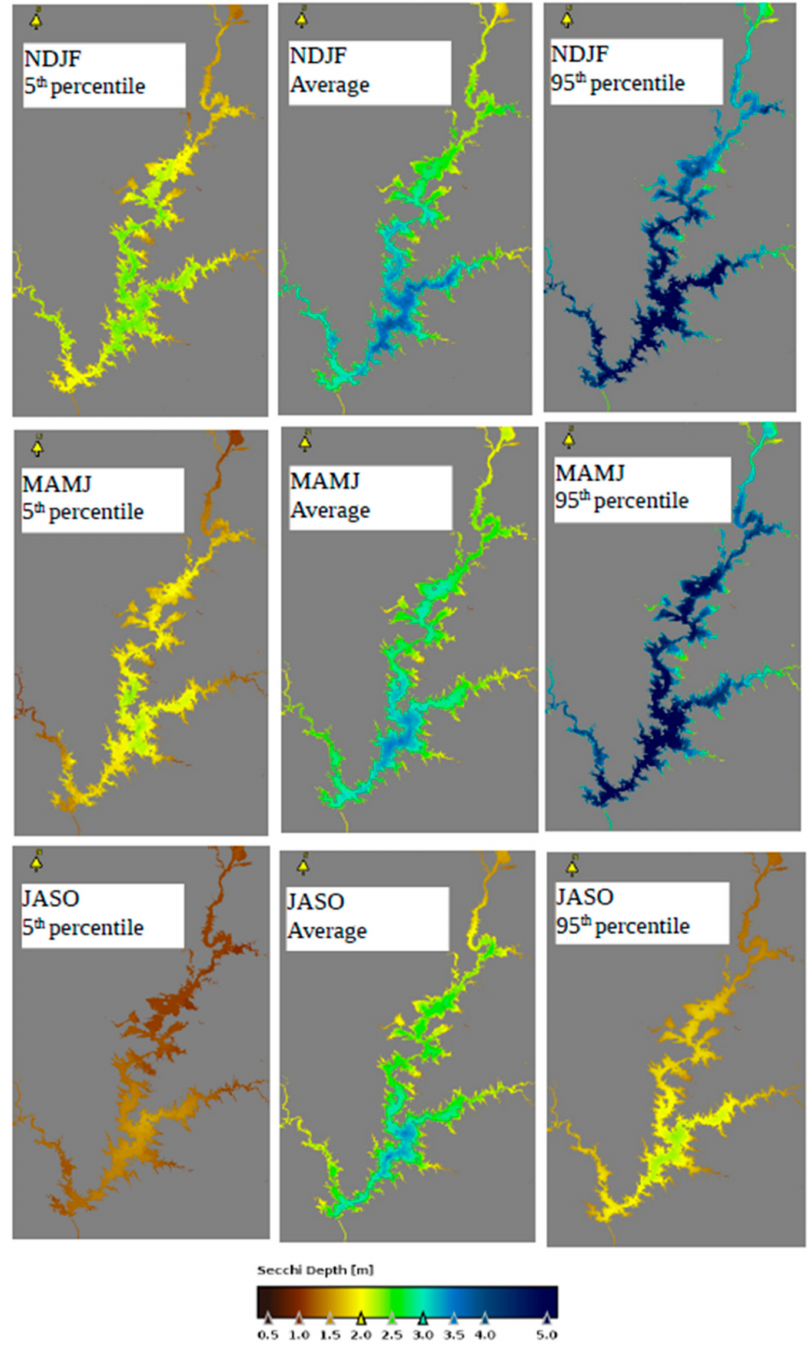
Figure 8. Spatial distribution of Secchi Depth shown from November to February (top), March to June (middle), and July to October (bottom) in Alqueva reservoir, for the period July 2017–June